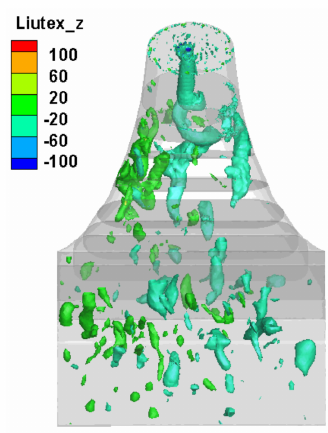
Figure 13. Vortex rope in draft tube. ( a ) α = 13.50 mm (small opening condition): ( a 1 ) Pressure iso-surface method, ( a 2 ) Q criterion, ( a 3 ) Liutex; ( b ) α = 26.17 mm: ( b 1 ) Pressure iso-surface method, ( b 2 ) Q criterion, ( b 3 ) Liutex; ( c ) α = 38.05 mm: ( c 1 ) Pressure iso-surface method, ( c 2 ) Q criterion, ( c 3 ) Liutex; ( d ) α = 48.74 mm (optimal condition): ( d 1 ) Pressure iso-surface method, ( d 2 ) Q criterion, ( d 3 ) Liutex.